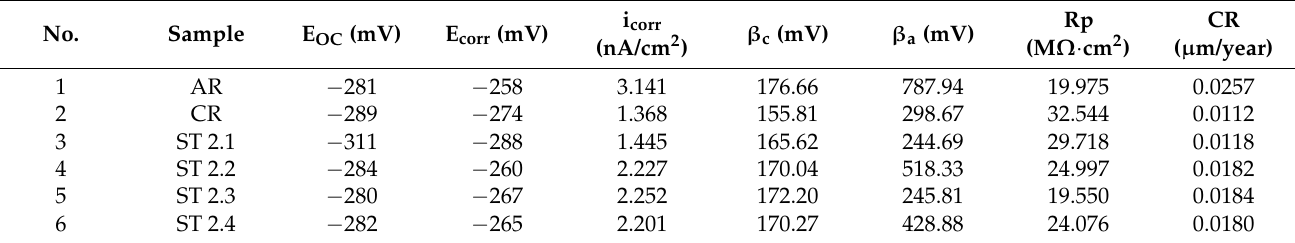
Table 8. Main corrosion parameters for TMP processed TNTZ